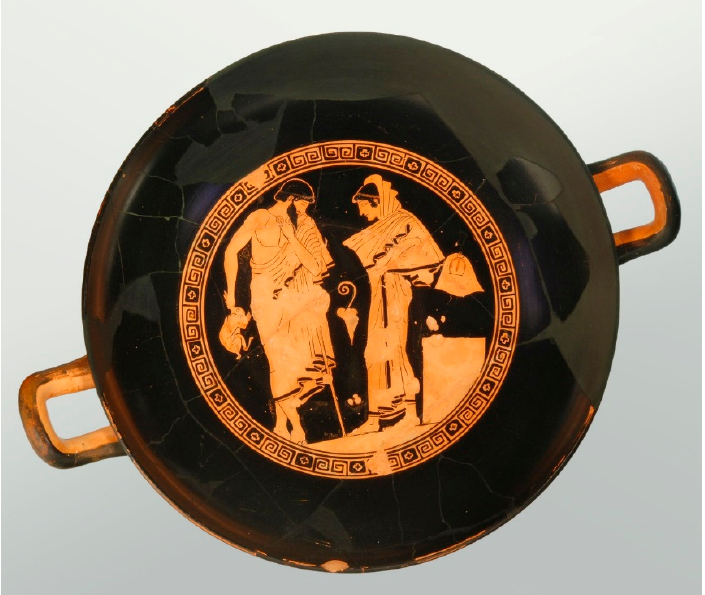
Figure 3. Interior of a kylix attributed to Douris. Würzburg, Martin von Wagner Museum 482. © Martin von Wagner Museum der Universität Würzburg. Photograph by P. Neckermann. Used by permission. 480–70 BCE.